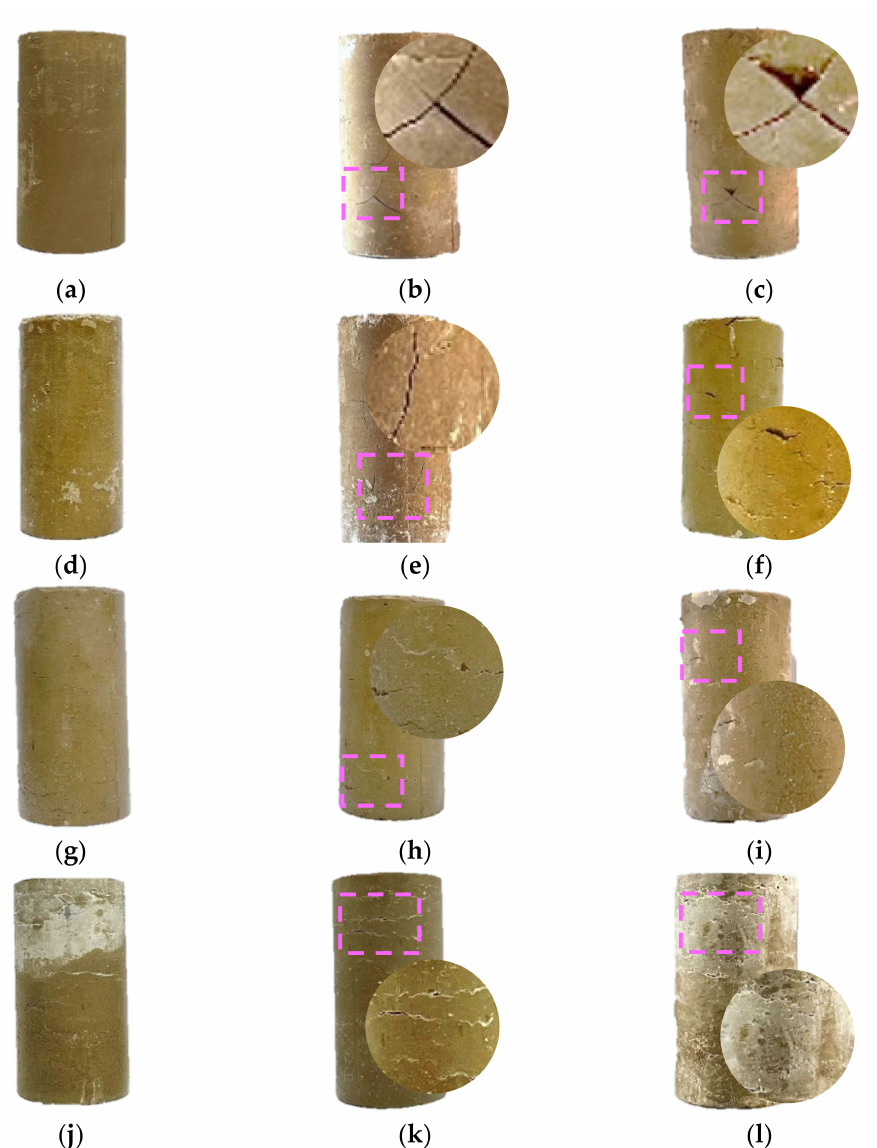
Figure 4. Surface damage of each group of specimens before and after freeze–thaw cycles: ( a ) LC-0 specimen group with 0 freeze–thaw cycles; ( b ) LC-0 specimen group with 2 freeze–thaw cycles; ( c ) LC-0 specimen group with 4 freeze–thaw cycles; ( d ) LC-6 specimen group with 0 freeze–thaw cycles; ( e ) LC-6 specimen group with 2 freeze–thaw cycles; ( f ) LC-6 specimen group with 4 freeze– thaw cycles; ( g ) LC-12 specimen group with 0 freeze–thaw cycles; ( h ) LC-12 specimen group with 2 freeze–thaw cycles; ( i ) LC-12 specimen group with 4 freeze–thaw cycles; ( j ) LC-18 specimen group with 0 freeze–thaw cycles; ( k ) LC-18 specimen group with 2 freeze–thaw cycles; ( l ) LC-18 specimen group with 4 freeze–thaw